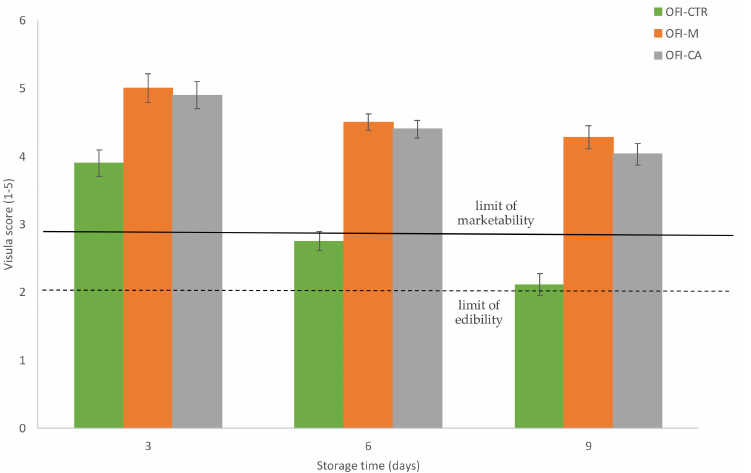
Figure 5. Visual score of minimally processed O. ficus-indica fruits non-treated (OFI-CTR) and treated with mucilage (OFI-M) and calcium ascorbate coating (OFI-CA) during cold storage (9 days at 5 ◦ C). Different lowercase letters indicate significant differences (Tukey’s test at p ≤ 0.05) between the treatments in each sampling date. Data are the mean ± SE (Vertical bars represent standard error; n = 5). [(5 = very good, 4 = good, 3 = fair (limit of marketability), 2 = poor (limit of edibility) and 1 = very poor (inedible)].